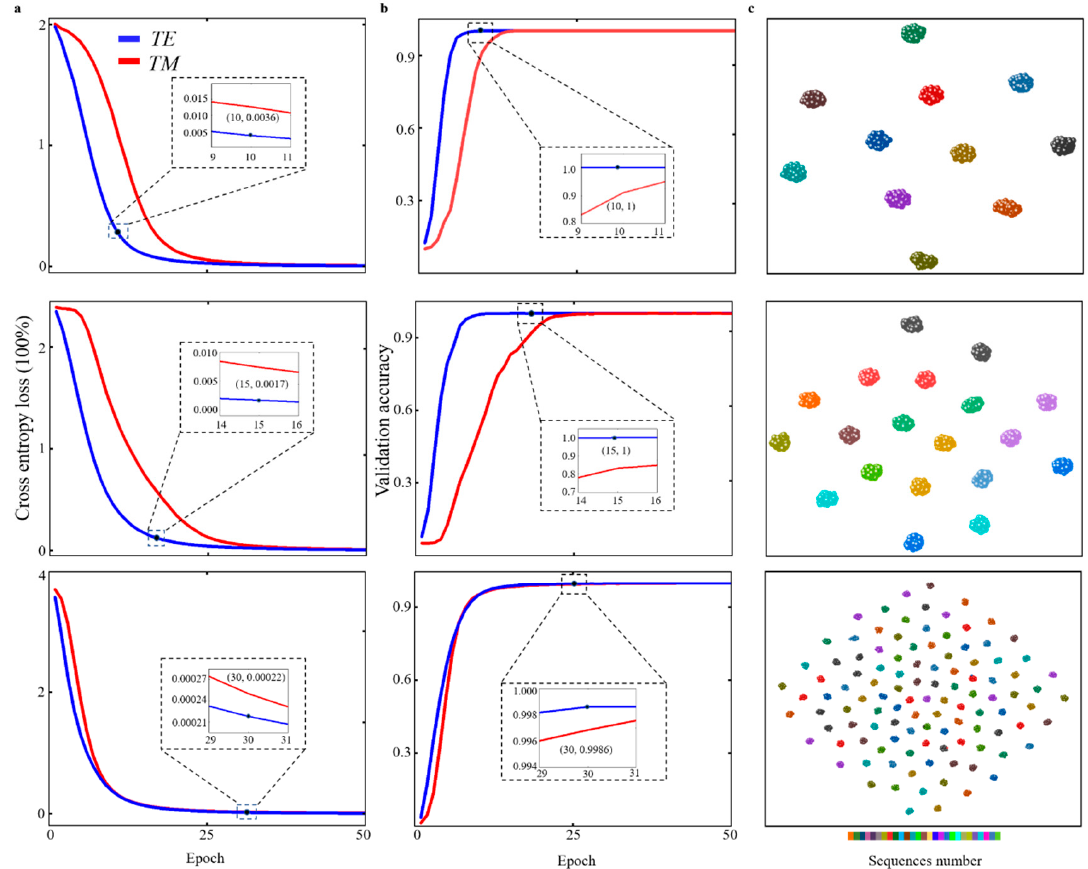
Figure 8. Demonstration of training quality and readout accuracy. ( a ) Cross-entropy loss for 12, 18, and 120 data sequences trained using TE polarization and TM polarization, ( b ) Validation accuracy for 12, 18, and 120 data sequences trained using TE polarization and TM polarization, ( c ) 12, 18, and 120 data sets of TE polarized training sets with a t-SNE spot.